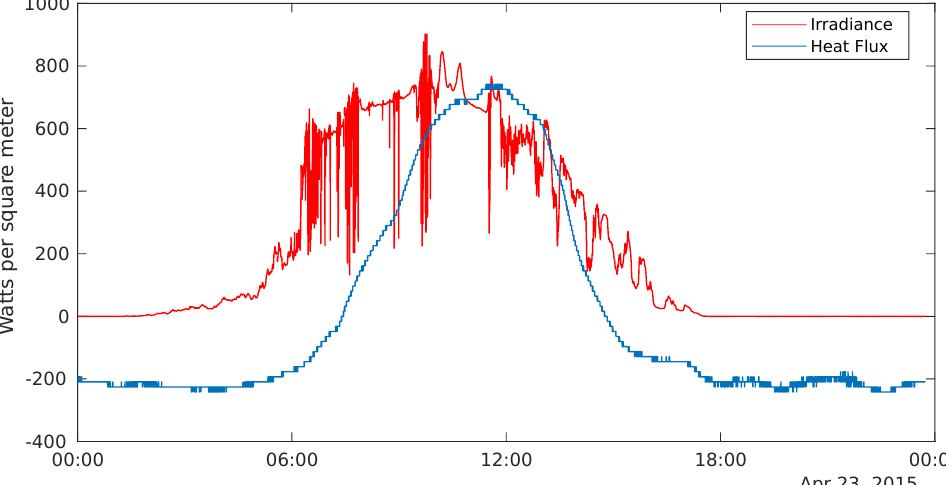
Figure 6. Solar irradiance, E e ( t ) [W/m 2 ] (pyranometer) and heat flux, φ [W/m 2 ] (heat flux plate), as a function of time ( h ) for the 23rd of April